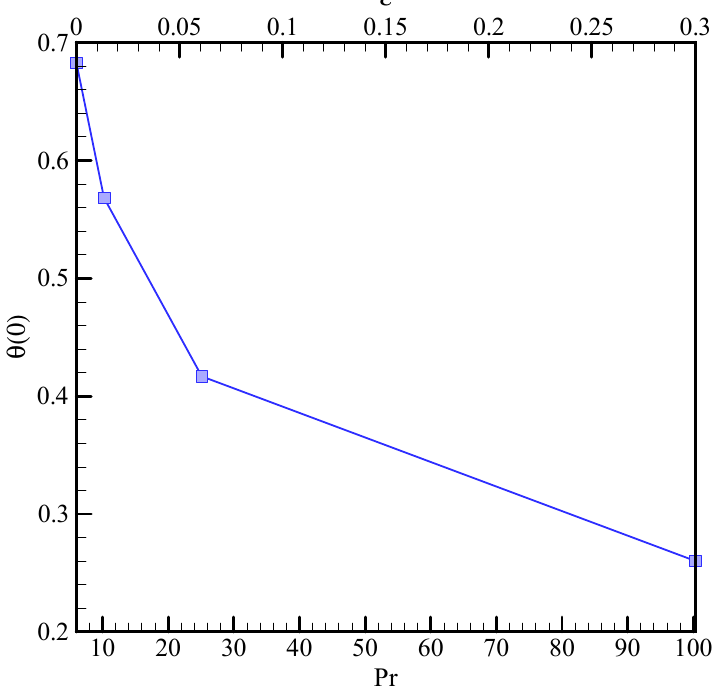
η = ) with respect to Pr